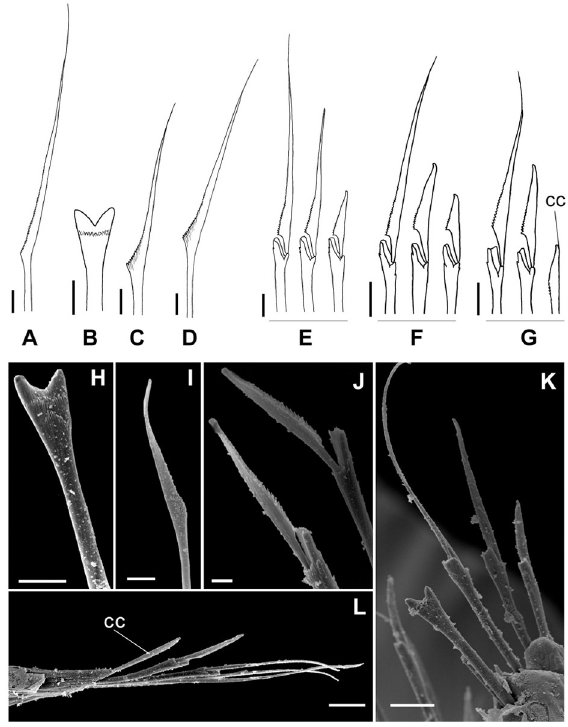
Fig 11. Meiodorvillea penhae sp. nov. (A) capillary chaeta, anterior region; (B,H) furcate chaeta; (C,D,I) geniculate chaeta;(E) compound chaetae, anterior region; (F) compound chaetae, median region; (G) compound and cultriform chaetae, posterior region; (J) compound chaetae; (K) chaetae, anterior region; (L) chaetae, posterior region. Abbreviations: cc = cultriform chaeta. Scale bars: (A-G) = 6.25 μ m; (H-I) = 5 μ m; (J) = 2 μ m; (K-L) = 10 μ